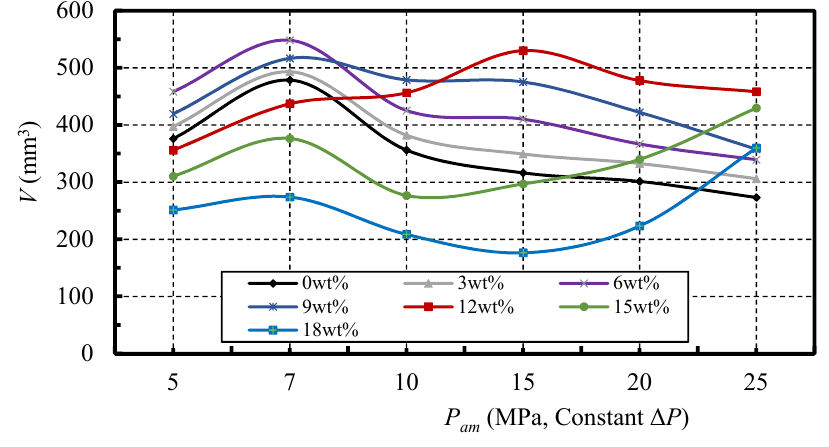
Figure 9. Rock erosion characteristics under various ambient pressures and constant Δ P .